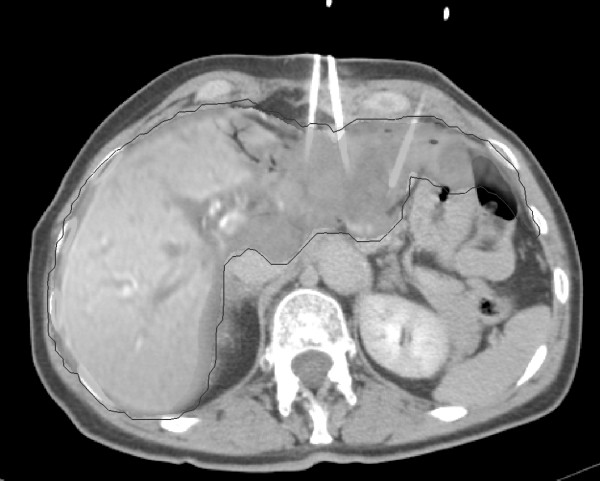
Image-fusion: Contrast-enhanced computed tomography (CT) after CT-guided positioning of brachytherapy catheters (arrows) in a liver metastasis of a colorectal carcinoma, merged with the last magnetic resonance imaging of the liver acquired after all interventions (grey delineation). The hypointensity area shows the impairment of hepatocyte function in the left liver lobe.